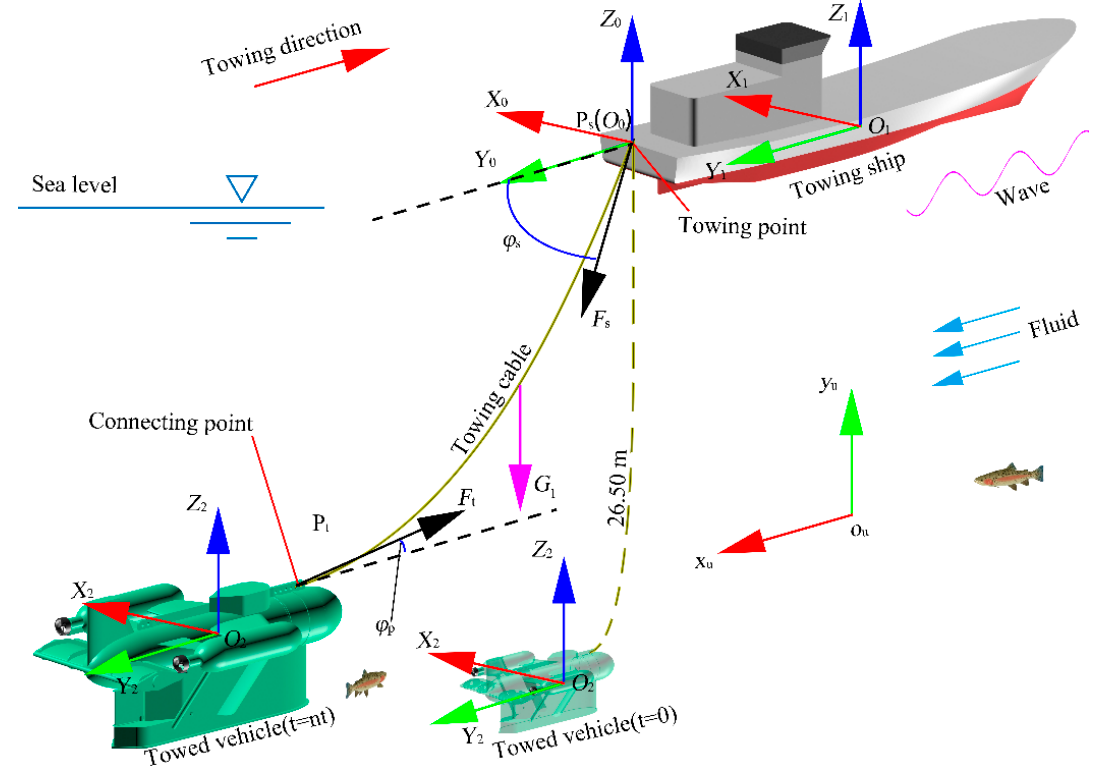
Figure 1. A schematic diagram of the underwater towed system.